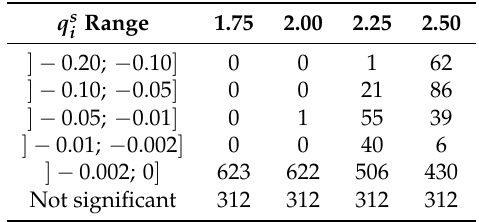
= 0 and q ∗ = 0 m 3 /h. i i q s i